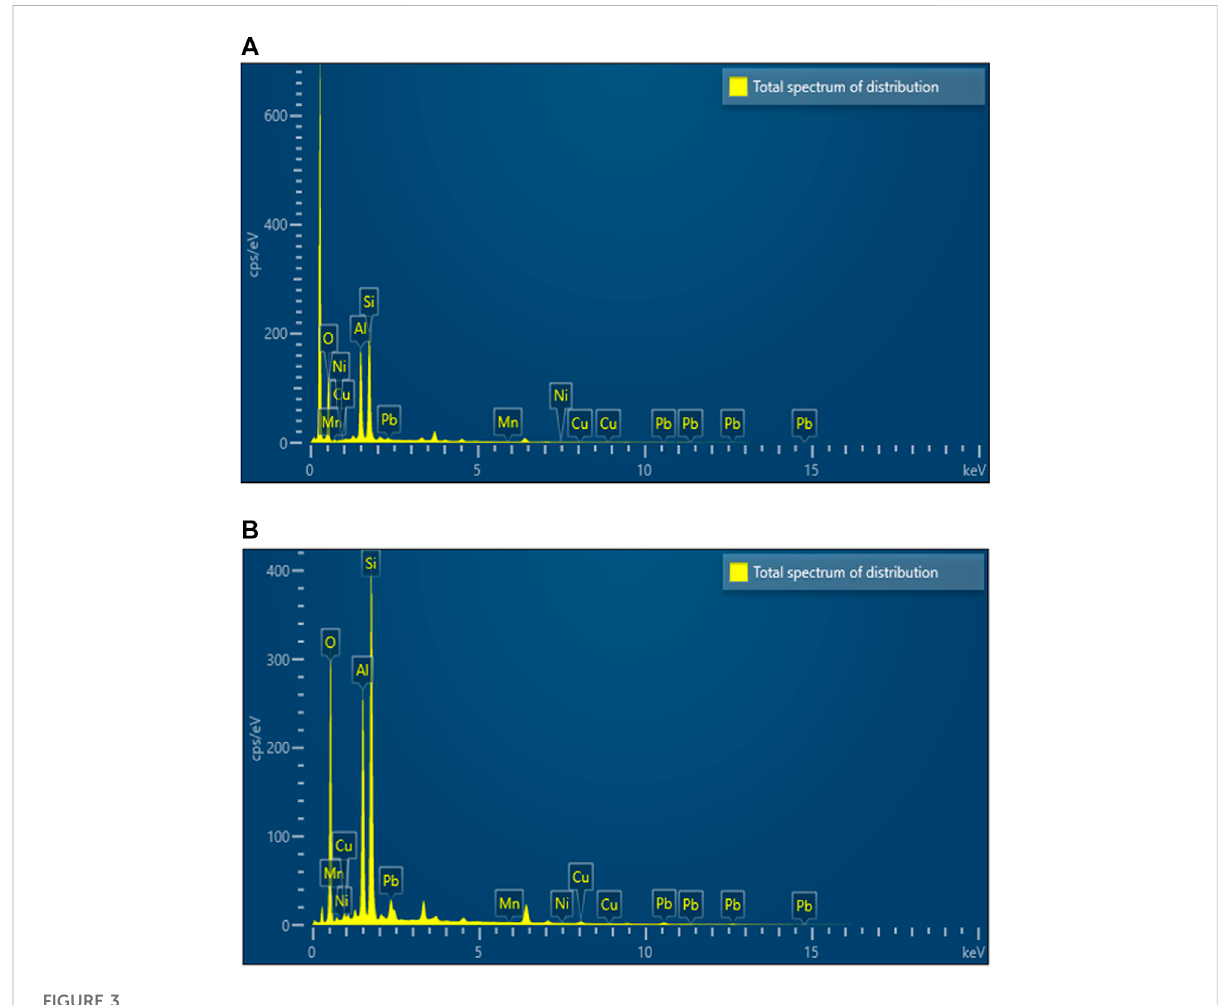
FIGURE 3 EDX spectrum composition of MCFA (A) and MCFA-HM (B)